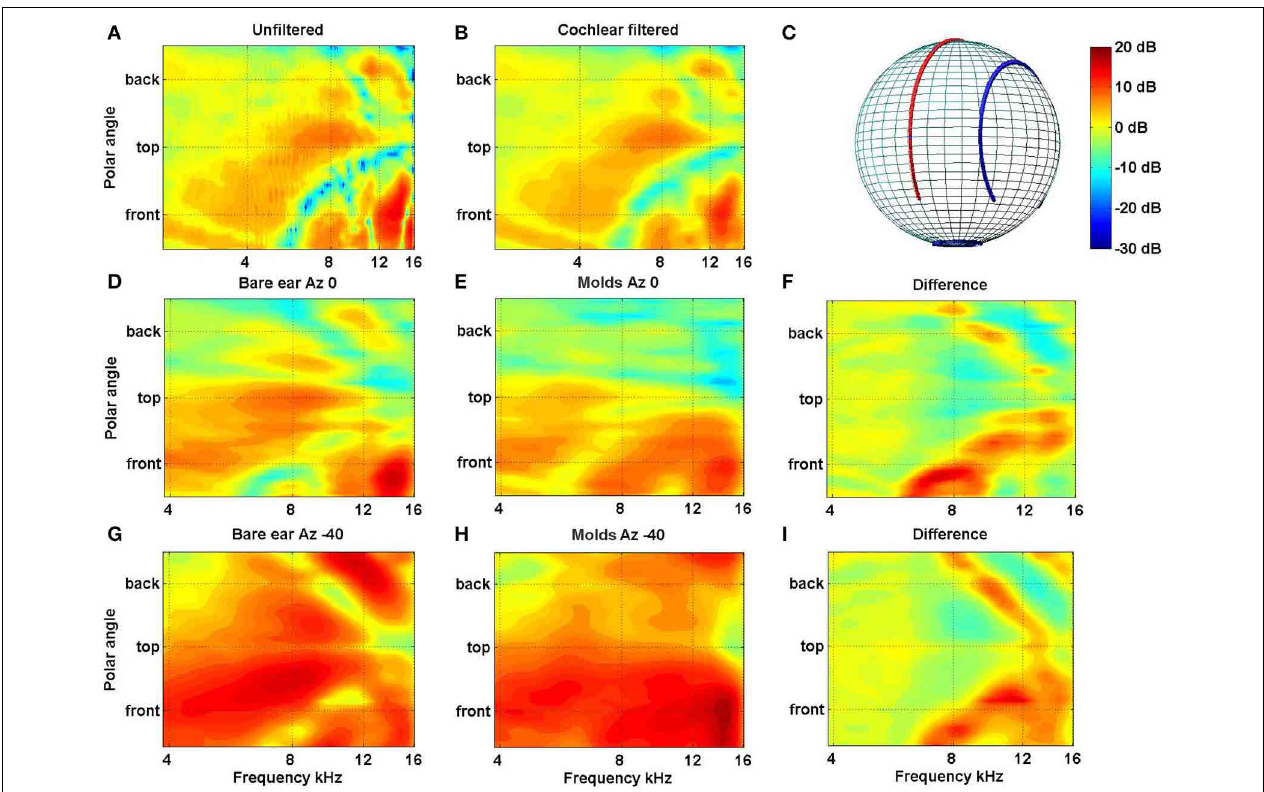
FIGURE 4 | (A) Filter functions of the left ear of one subject are plotted for the midline cone of confusion before and (B) after passing through a cochlear filter model. The features in (B) indicate that, despite the frequency filtering and spectral smoothing produced by the cochlear, substantial spectral features are preserved within the auditory nervous system. Filter functions for the left ear of a different subject are